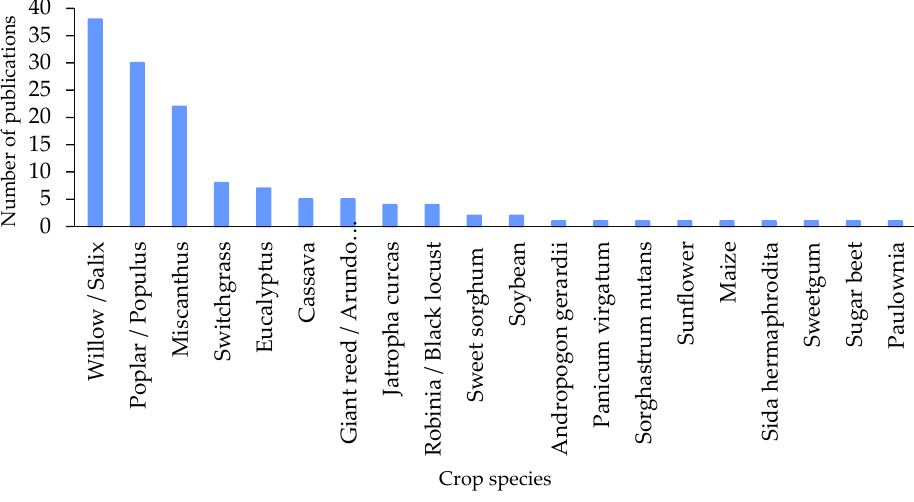
Figure 6. Frequency of references to crop species in articles concerned with economic analysis of perennial crops for energy.